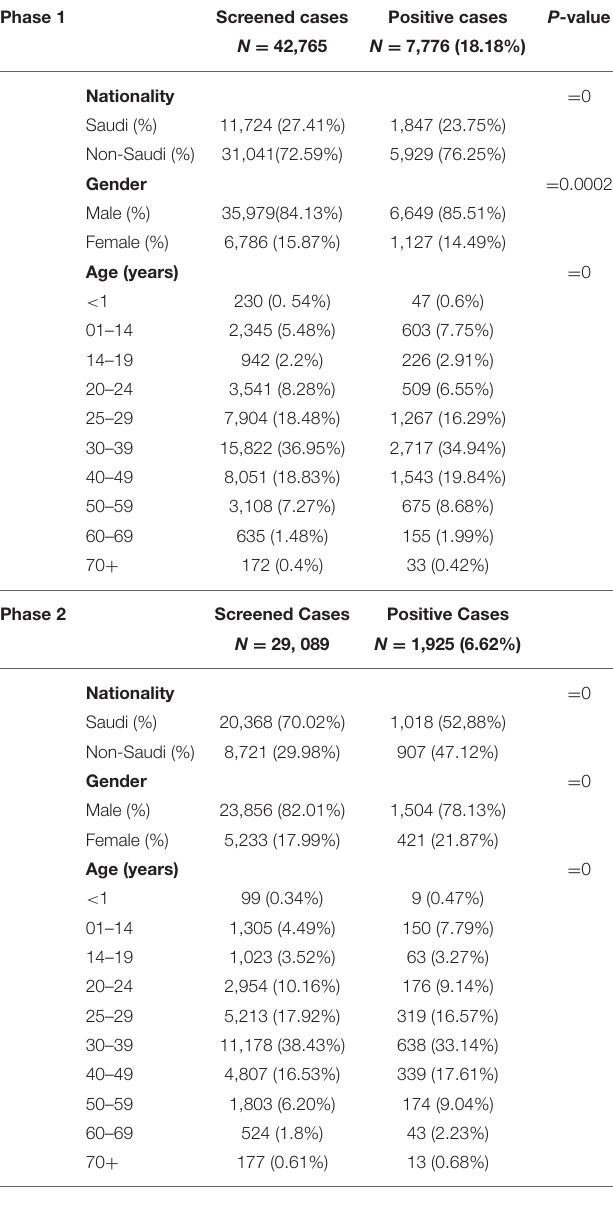
TABLE 1 | Demographic variables for COVID-19 positive cases during active and community phases for mass screening. Phase